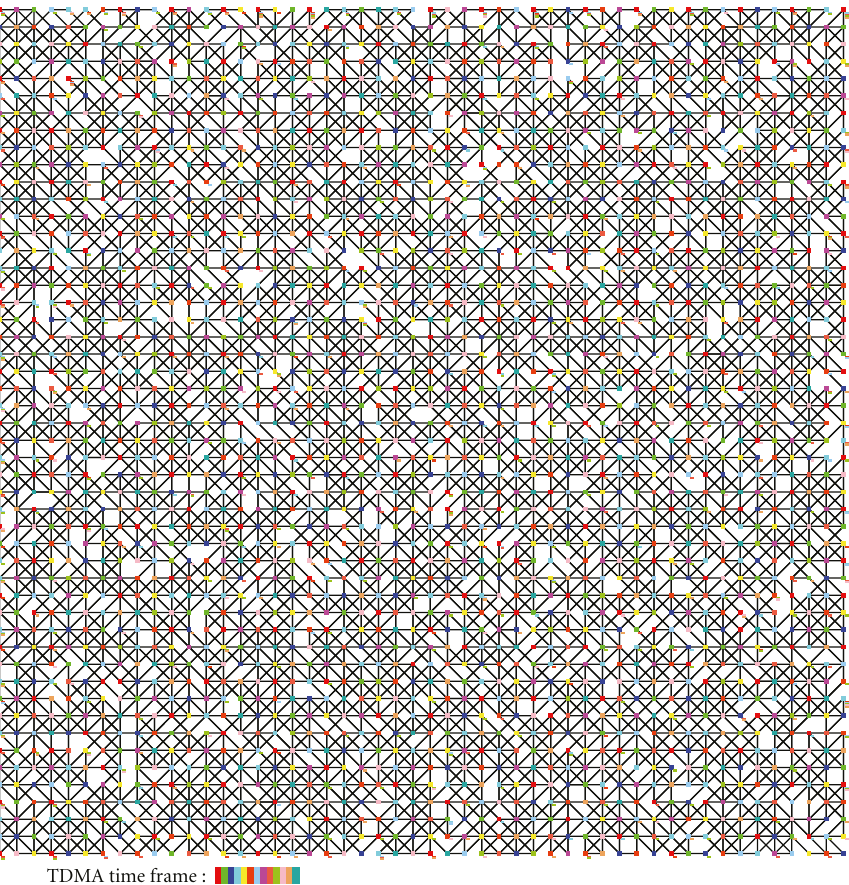
Figure 3: The broadcast scheduling for the seventeenth instance in Table 3 with our ILS